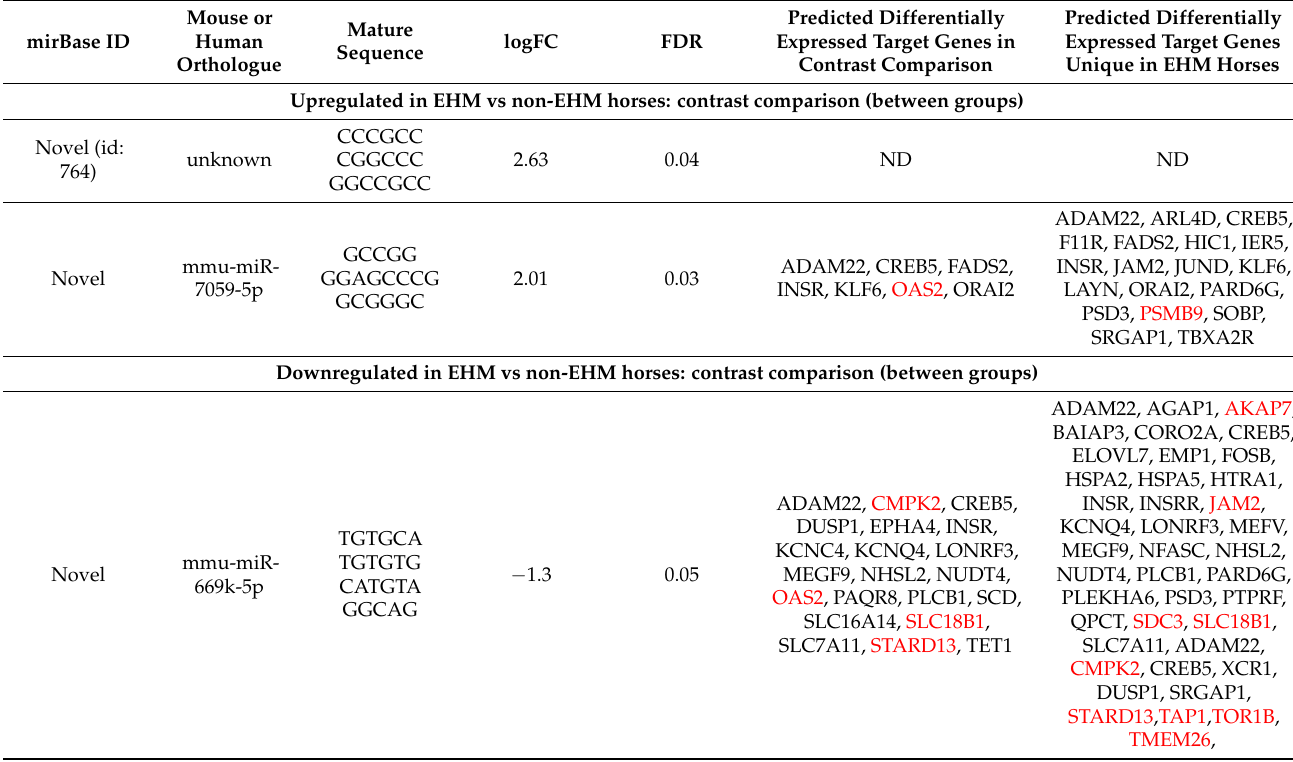
Figure 12. Micro RNA expression analyses. Principal component analysis (PCA) plot for miRNA read counts. Principal component analysis was performed on the read count data obtained after miRNA sequencing. Brown closed diamonds indicate samples from non-EHM horses post EHV-1 CH, brown open circles indicate samples from non-EHM horses prior to EHV-1 CH, blue closed squares indicate samples from EHM horses post EHV-1 CH, and blue open squares indicate sam-ples from EHM horses prior to EHV-1 CH. Table 3. Differentially expressed